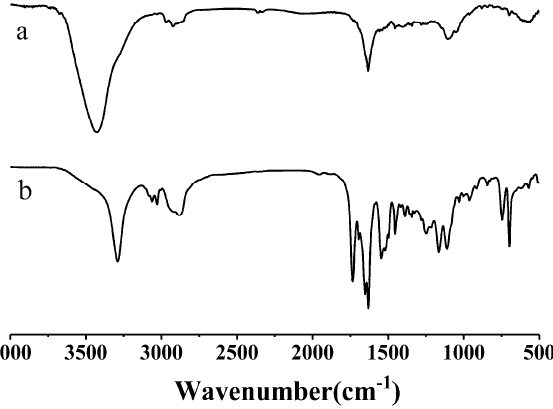
Figure 2. 1 H NMR of mPEG-poly(BLG)-PPA ( A ) and mPEG-PLGA-PPA ( B ) in DMSO-d 6.